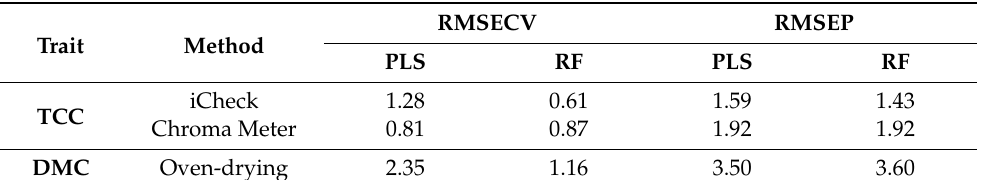
Table 3. The root mean square error of cross-validation (RMSECV), and the root mean square error of prediction (RMSEP) of TCC using iCheck and Chroma Meter evaluation methods and DMC under different calibration methods: partial least square (PLS) and random forest (RF).